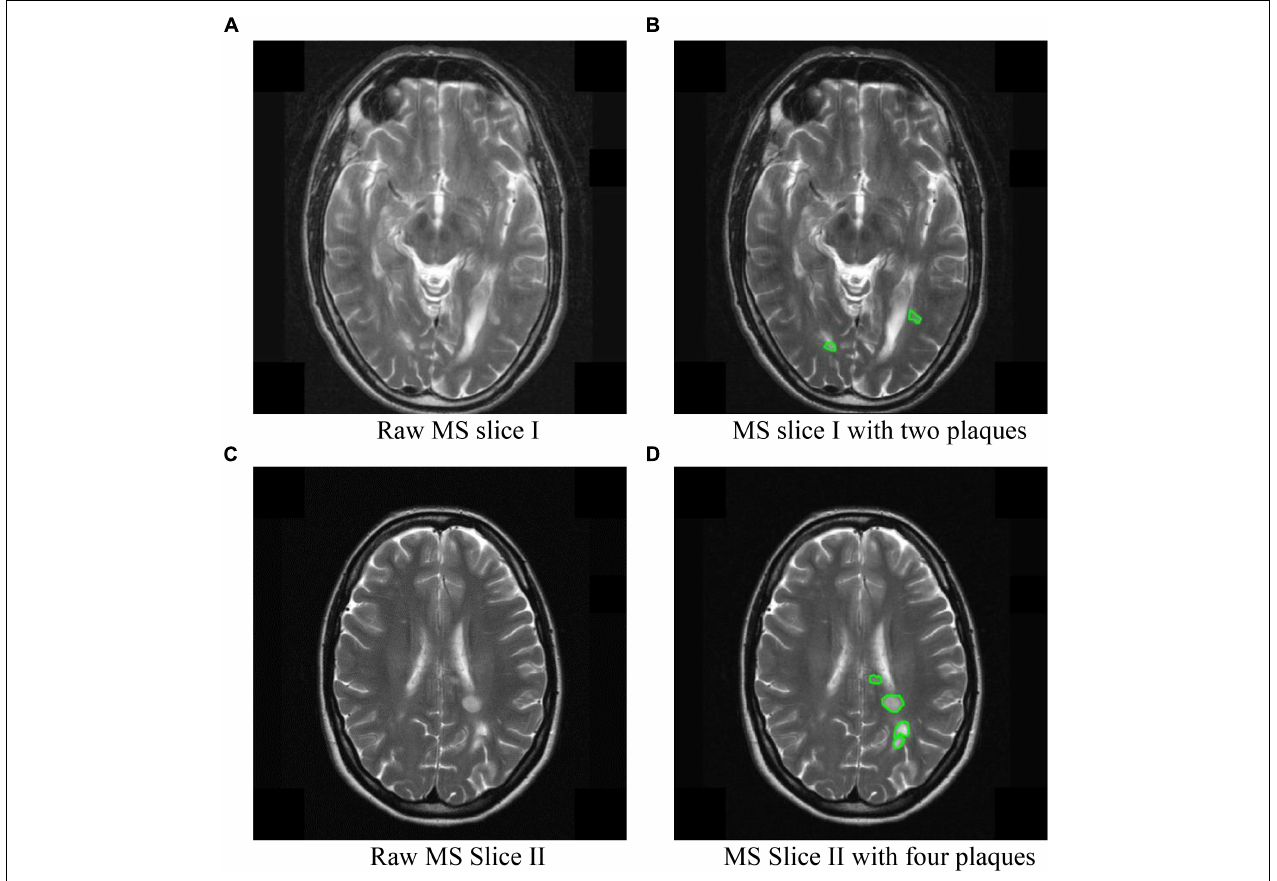
FIGURE 1 | MS samples. (A) Raw MS slice I. (B) MS slice I with two plaques. (C) Raw MS Slice II. (D) MS Slice II with four plaques.